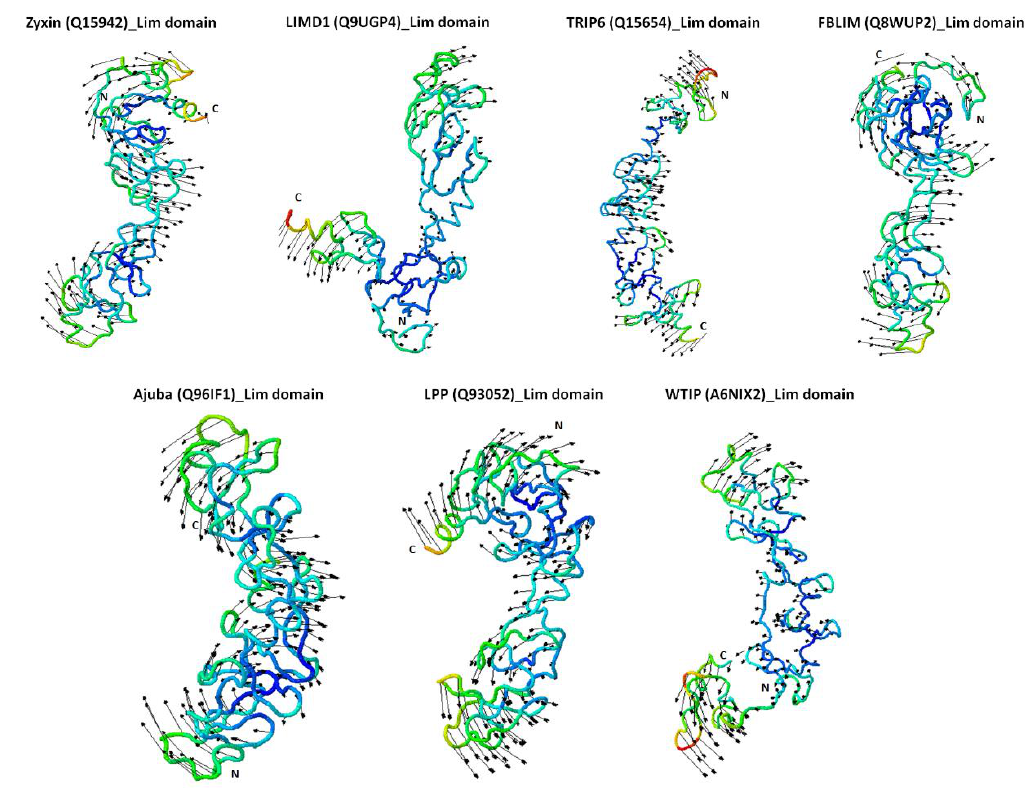
334 Figure 4. Normal mode analysis (NMA) of Zyxin family Lim domain proteins. The NMA for each protein model was